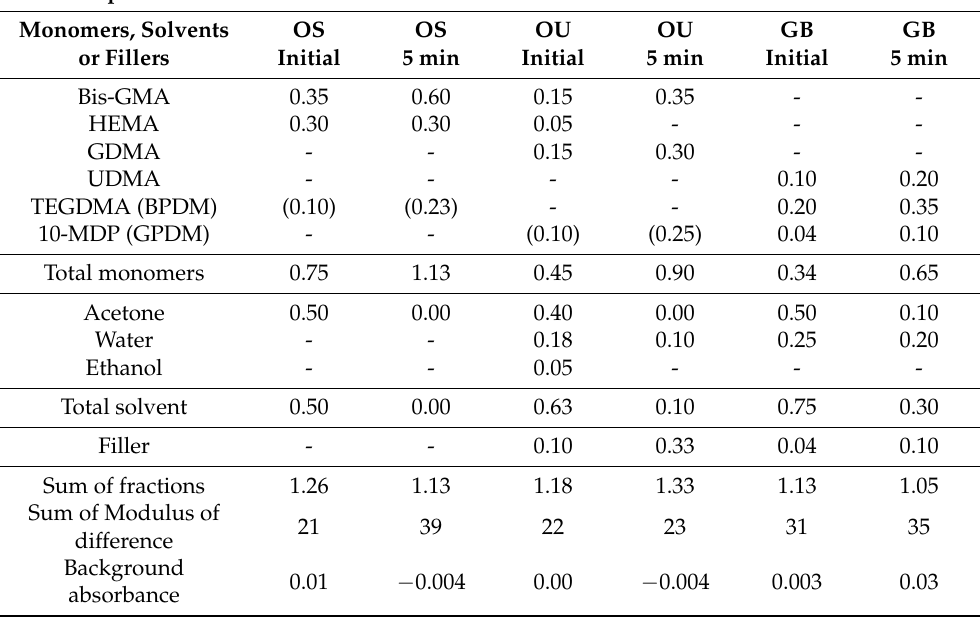
Table 3. Summary table of the fractions of pure chemical and filler spectra used to obtain the model spectra for the different adhesives initially (initial) and after acetone evaporation (at 5 min) but before cure. Deviation of the sum of fractions and modulus of differences between actual and model spectra from 1 and 0, respectively, demonstrate level of model fit. Values in brackets show where TEGDMA and 10-MDP have been used as models for BPDM and GPDM, respectively, for which pure chemicals were